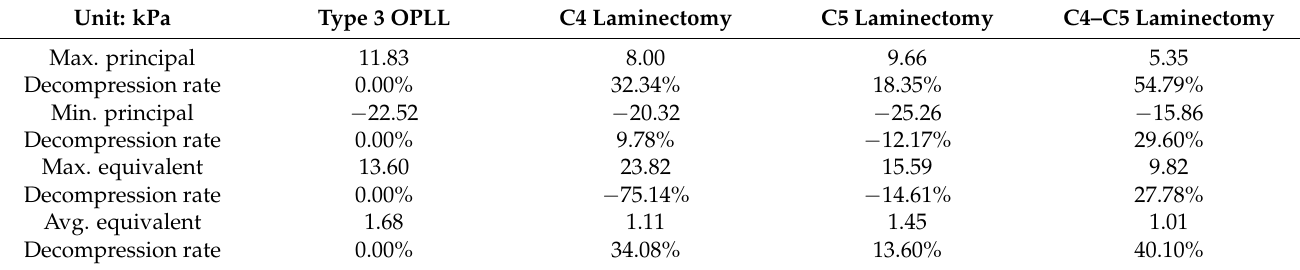
Table 9. Flexion laminectomy simulation spinal cord stresses: type 3